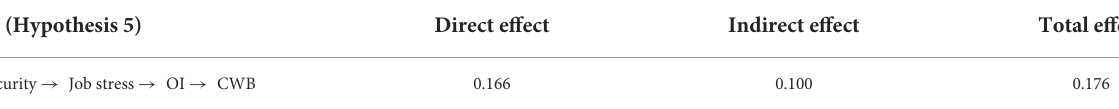
TABLE 4 Direct, indirect, and total effects of the final research model.